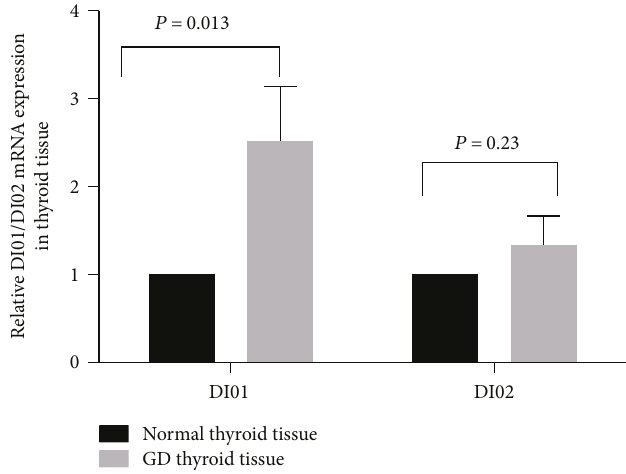
Figure 4: Relative DIO1/DIO2 mRNA expression levels in the thyroid tissue of Graves ’ disease and normal thyroid